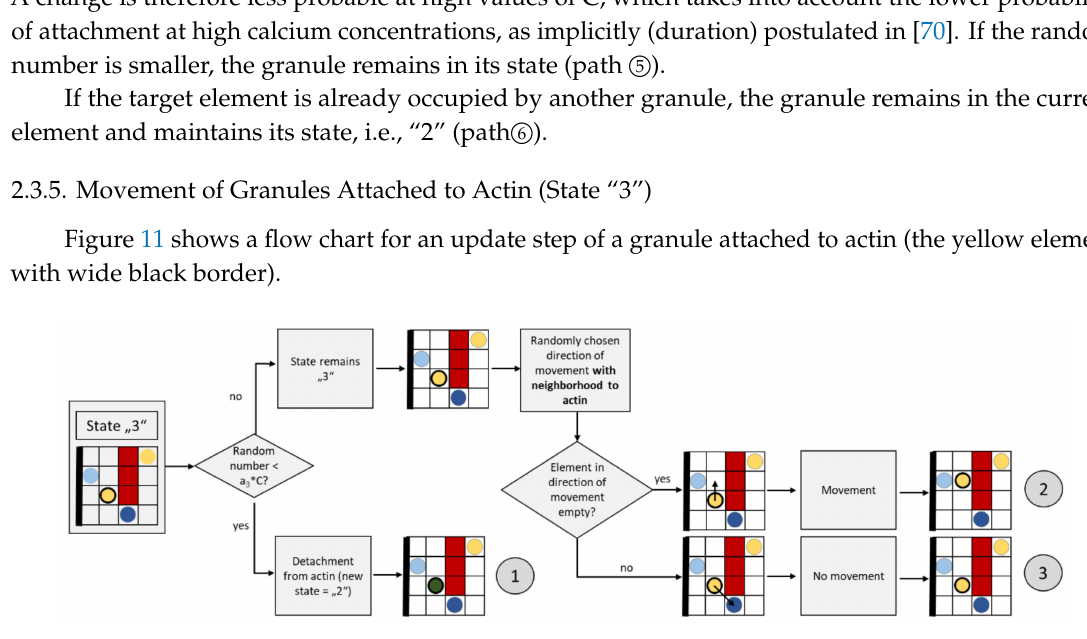
Figure 11. Flowchart for the update rule of a granule attached to actin (state “3”).